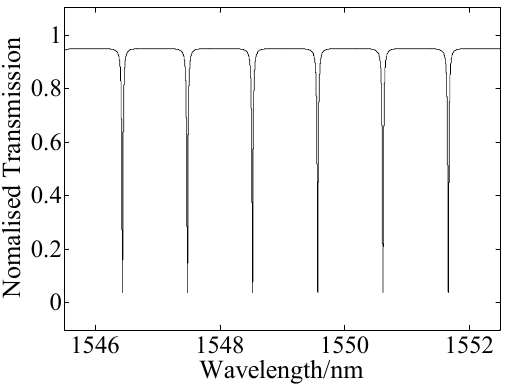
Figure 1. Schematic diagram of optical field transmission of a two-path ring resonator.